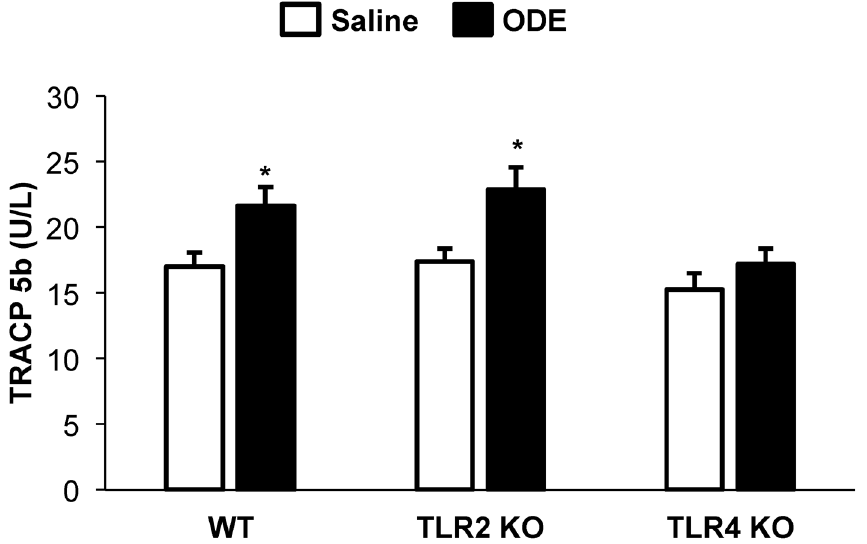
Fig 6. Repetitive inhalant ODE exposure increased serum TRACP 5b levels in WT and TLR2 KO but not TLR4 KO animals. WT, TLR2 KO, and TLR4 KO mice were i . n . treated with ODE daily or saline for 3 weeks whereupon animals were euthanized 5 hrs following final exposure. Levels of tartrate-resistant acid phosphatase 5b (TRACP 5b) were determined in serum. Bar graphs represent the mean with standard error bars shown (N = minimum of 6 mice/group from 3 independent studies). Statistical significance denoted by asterisks ( * p < 0.05) as compared to respective saline treatment group.